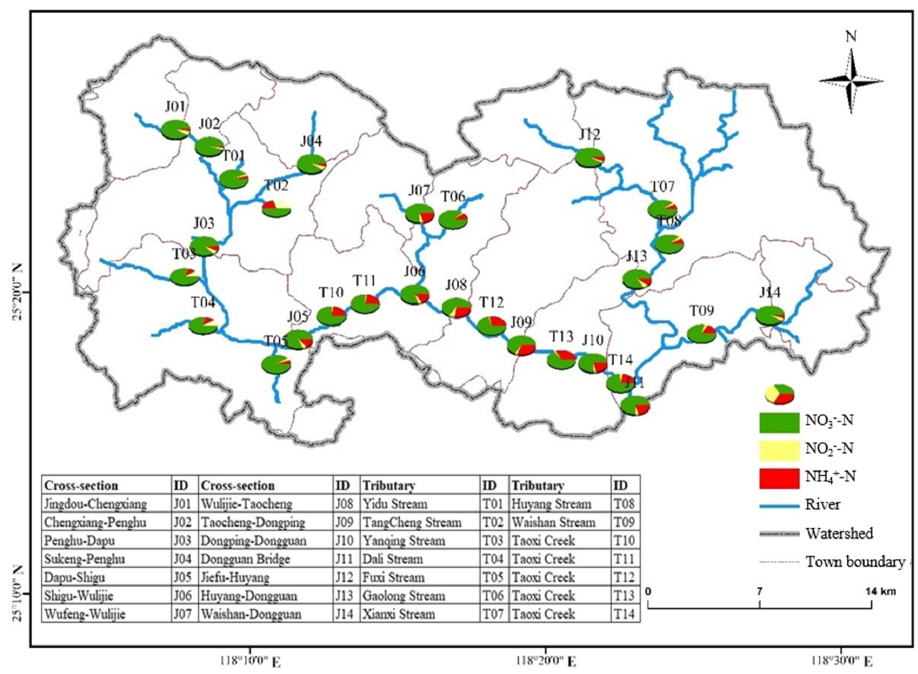
Figure 3. Spatial distribution of DIN components in Taoxi Creek.